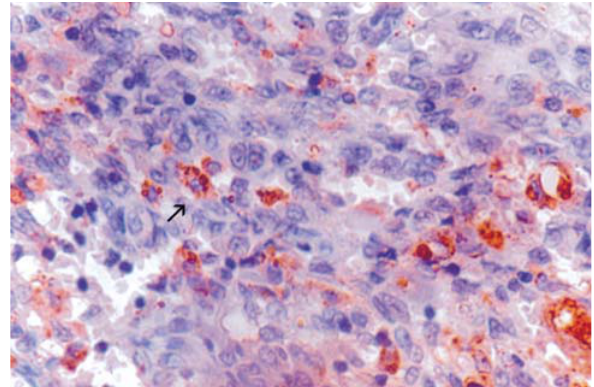
FIGURE 1 - Multinucleated giant cells and individual mononuclear cells CD68 positive in central giant cell granuloma of the jaws (arrow) (SABC – 200x)